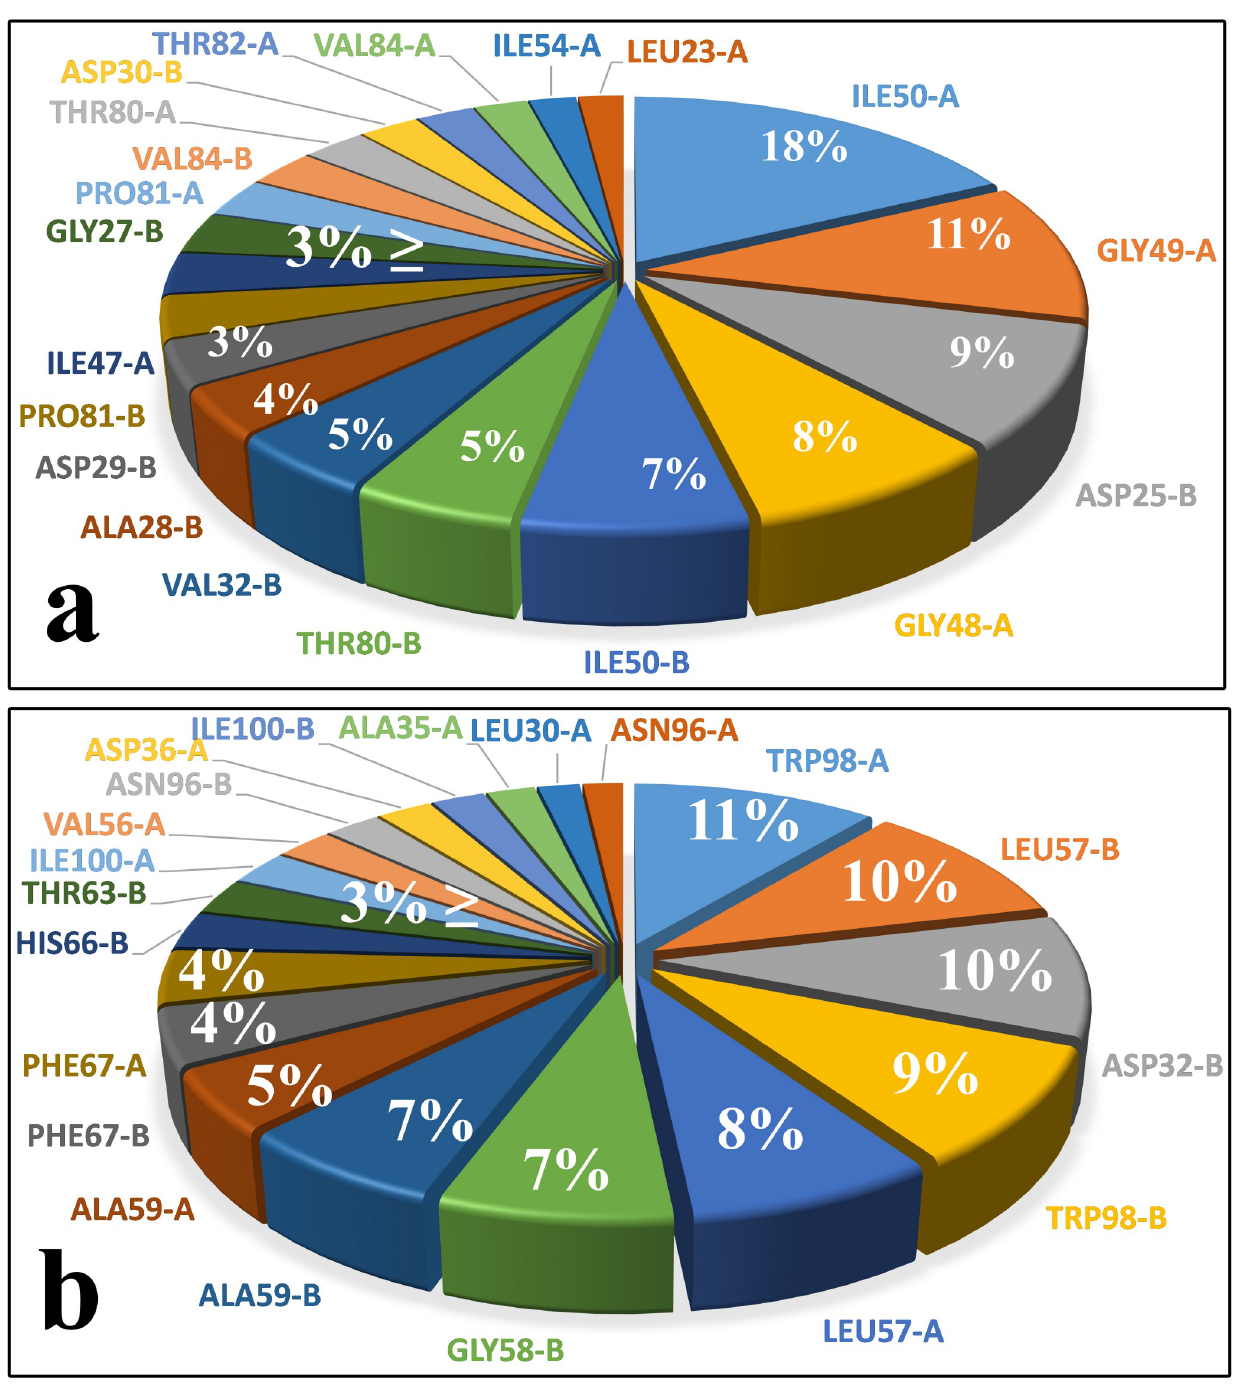
Fig 5. The contribution of each residue from both A and B chains of the proteases in the total interaction energies between Indinavir and the enzyme in the unbinding pathways. a, Indinavir-HIV protease complex, 1 st replica. b, Indinavir-HTLV-1 protease complex, 2 nd replica. A and B stands for "Chain A" and "Chain B", respectively. This data is the average interaction energy of each residue during the entire SuMD simulation.